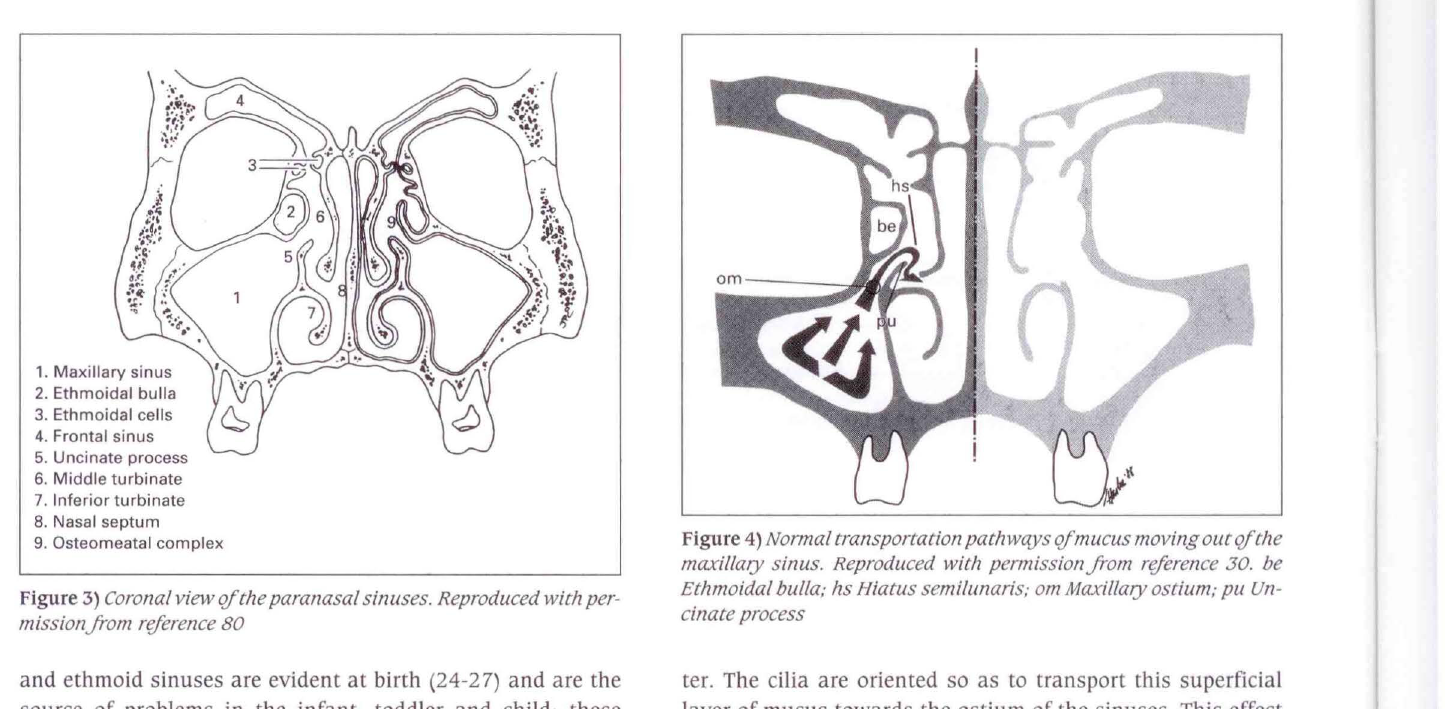
Figure 3) Coronal view qf the para nasal sinuses. Reproduced with per mission.from reference 80